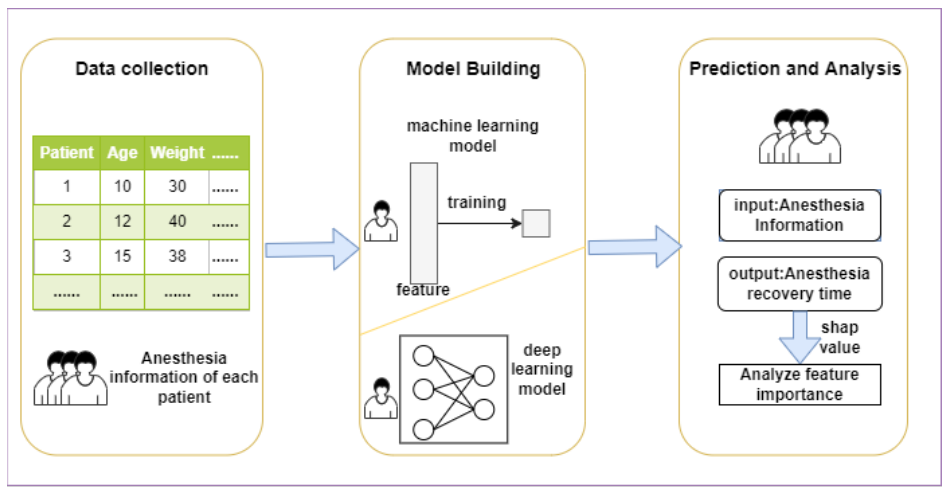
Figure 1. The workflow of this research. We first collect data from the eye center. Then we adopt machine learning models and the proposed deep learning models to predict anesthesia recovery time. we last analyze features’ importance by SHAP